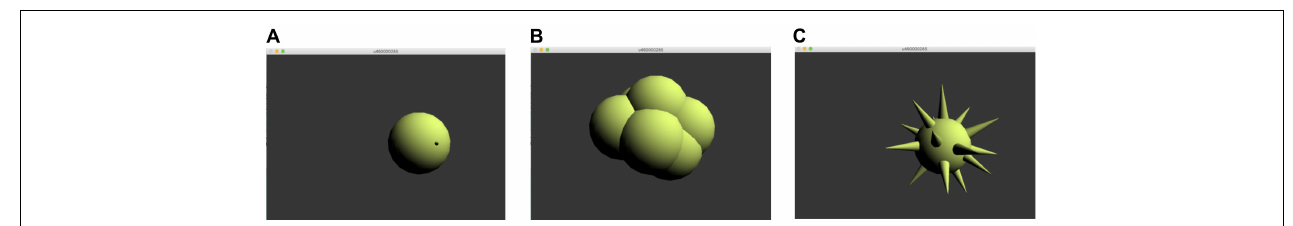
FIGURE 2 | (A) default object, (B) object at maximum curviness, and (C) object at maximum spikiness.